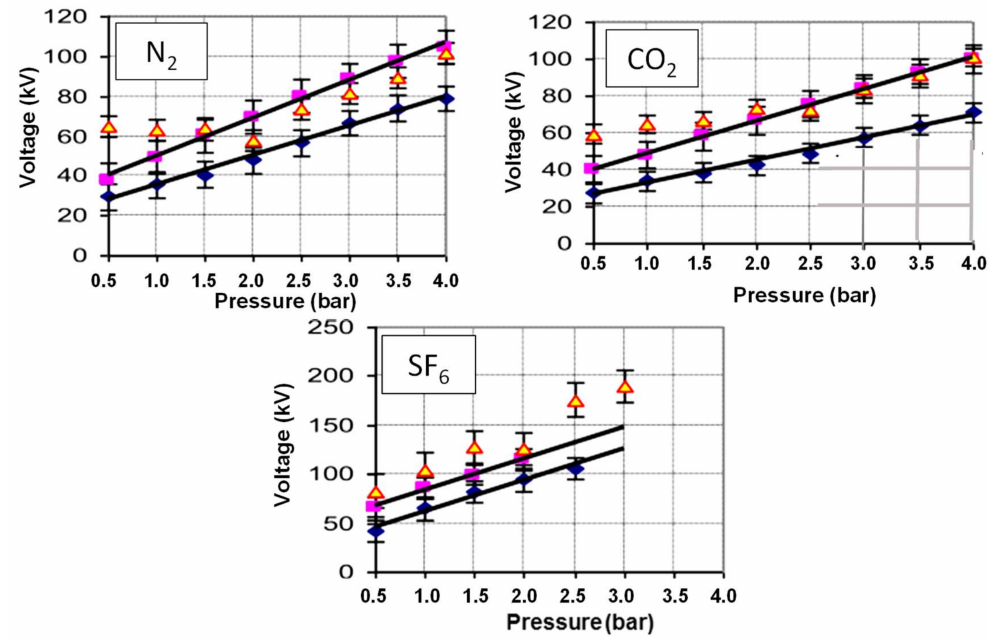
Figure 8. Comparison of the breakdown voltages of each of the investigated gases in the sphere–sphere electrode arrangement for AC ( ), negative ( ) and LI ( ) voltages; electrode gap d = 10